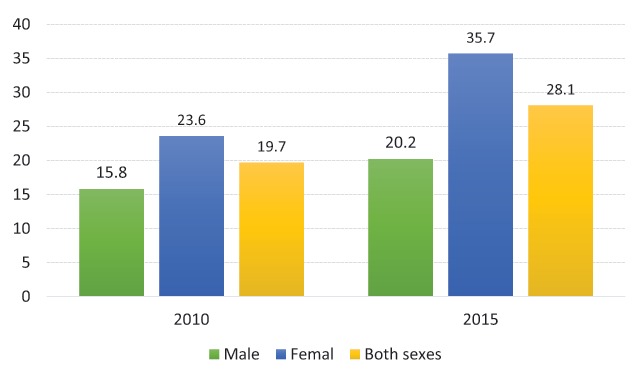
Prevalence of low physical activity, adults aged 25–64 years (Unit: %) [182032474849].